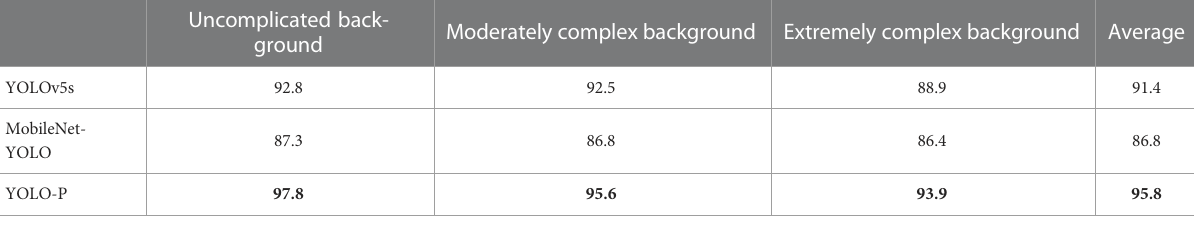
or slightly shaded pear images. All three networks detected the target accurately. Figures 11D – F are medium-shaded pear images. YOLOv5s and YOLO-P detected all targets. Neither of the two shaded fruits was successfully detected by MobileNet- YOLO. Figures 11G – I are serious-shaded pear images. YOLOv5s